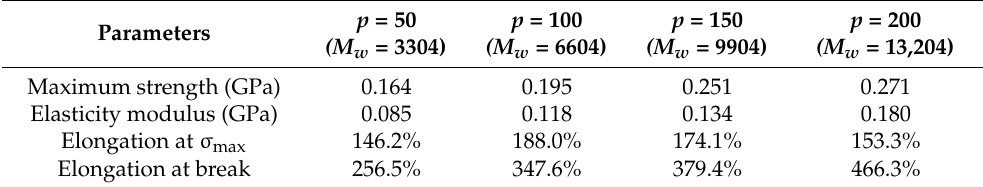
Table 1. Mechanical property parameters of PI with different p .